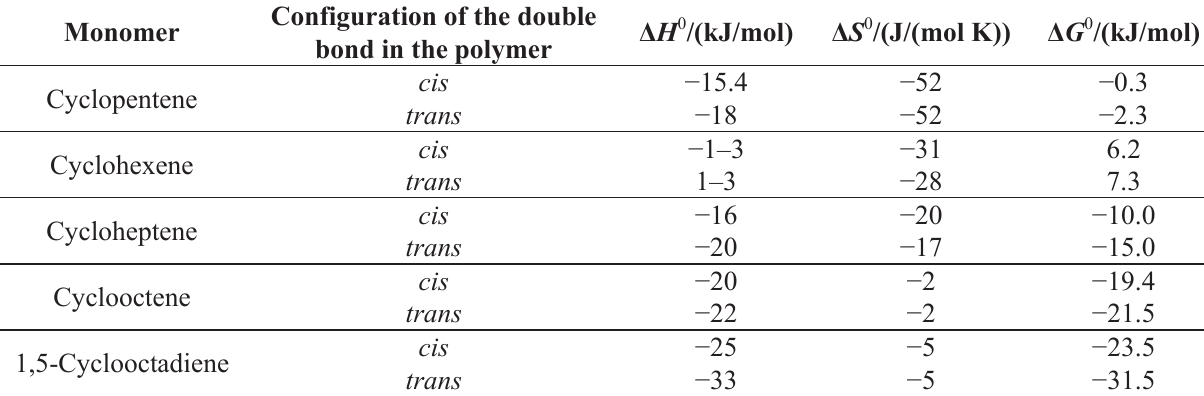
Table 5. Thermodynamic parameters for the ROMP of a selection of liquid monomers to amorphous polymers at 25 °C [129,130].